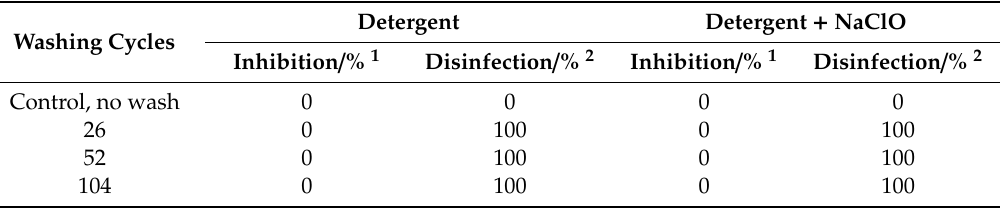
Table 3. Antibacterial properties of untreated samples washed by